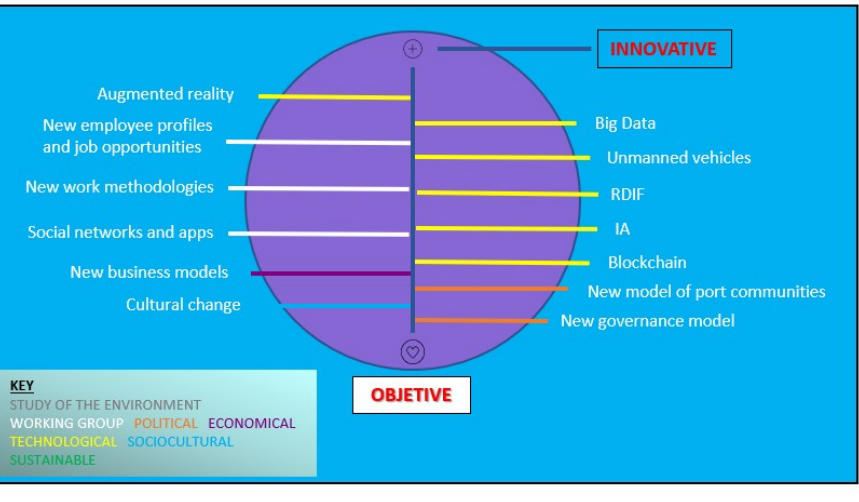
Figure 21. Elements of innovative ports. Source: own elaboration. In order to achieve more agile ports, technological indicators must be supported by institutional policies and environmental studies.